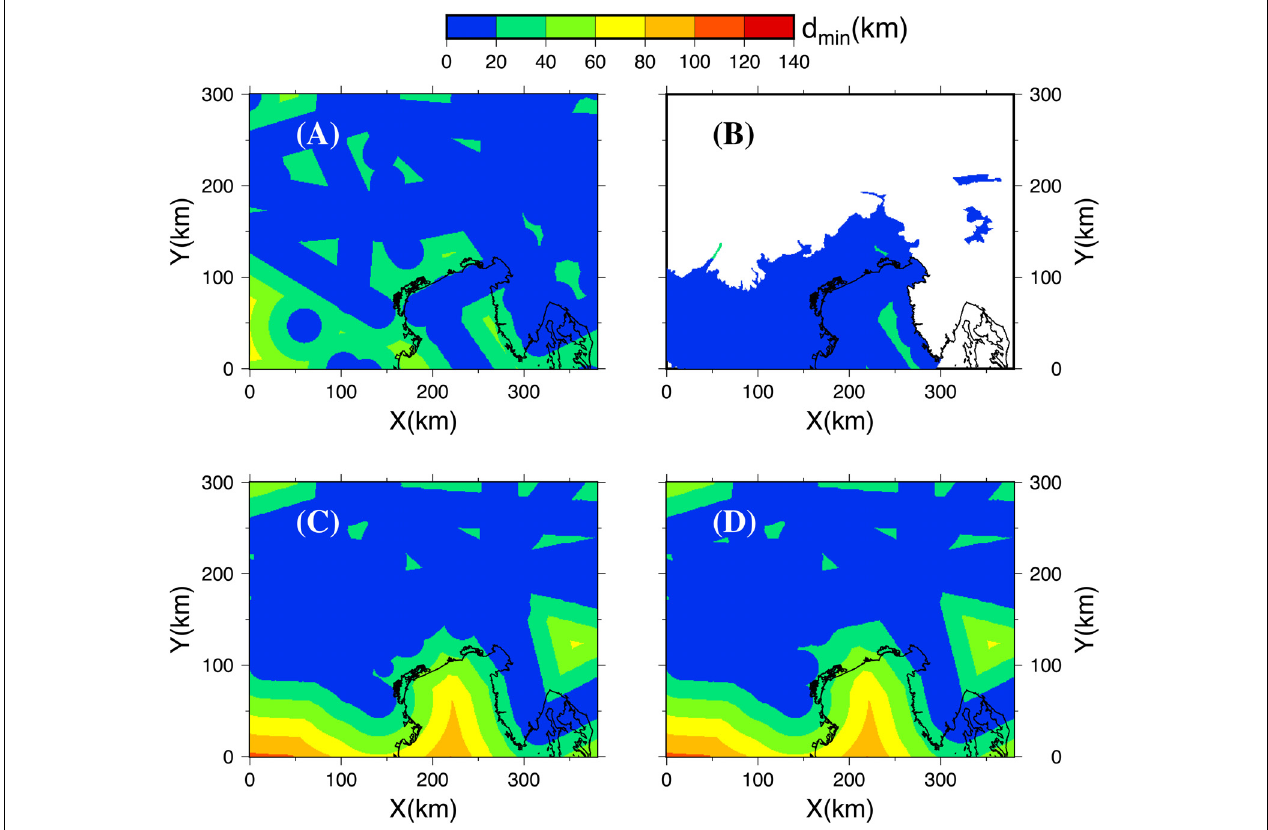
FIGURE 3 | Minimum distance between the points of the model and the data locations (d min ). (A) MO1 interface; (B) BS interface; (C) V P at 5 km; (D) V P at 25